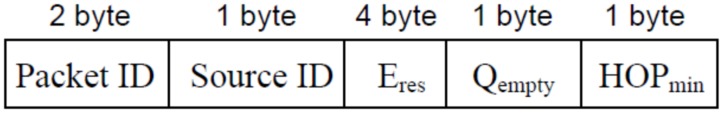
Hello message structure.